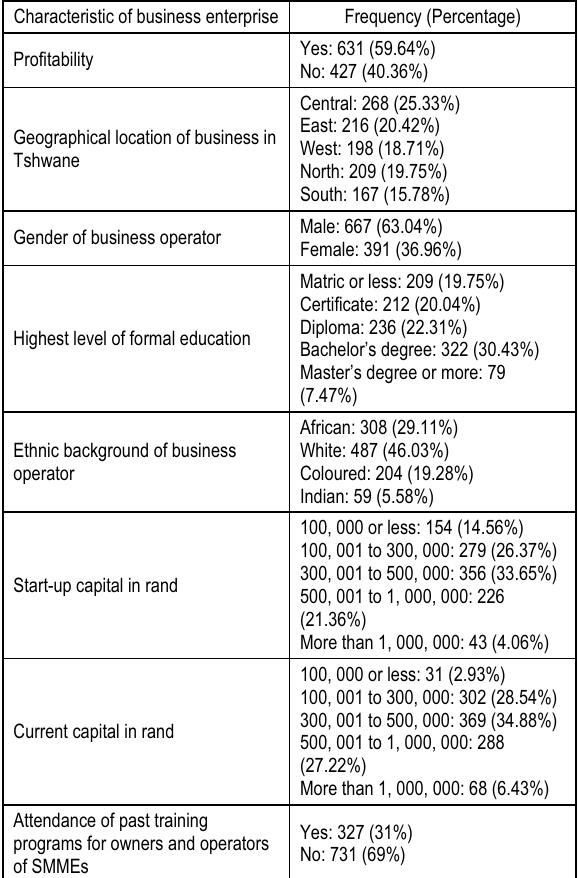
Table 1. Socioeconomic characteristics of SMMEs ( n =